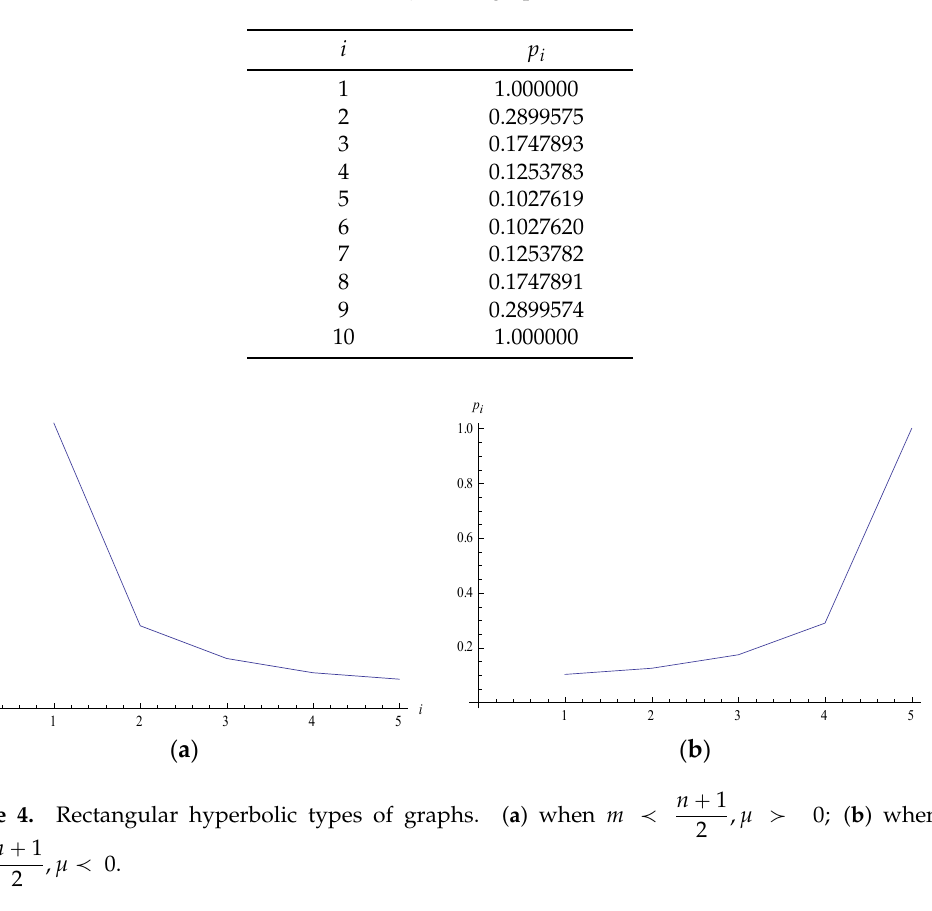
n ` 1 , µ ą 0; ( b ) when 2